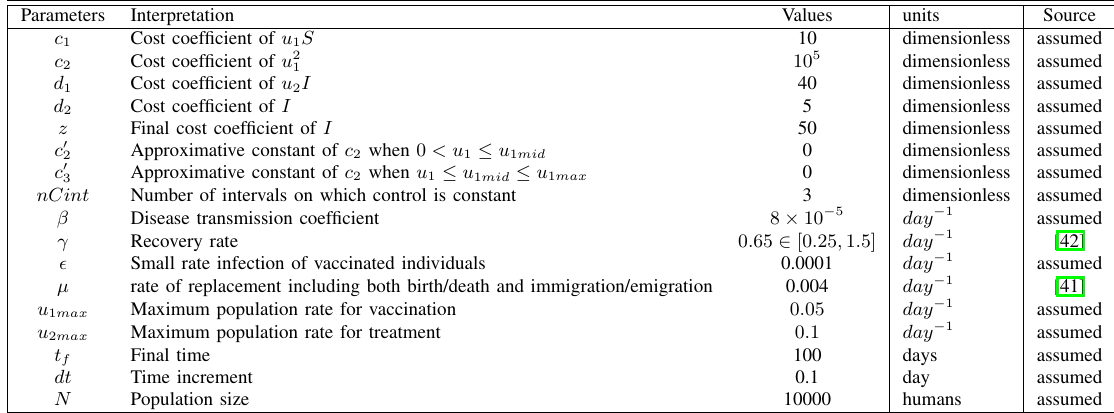
B ASELINE PARAMETERS USED IN